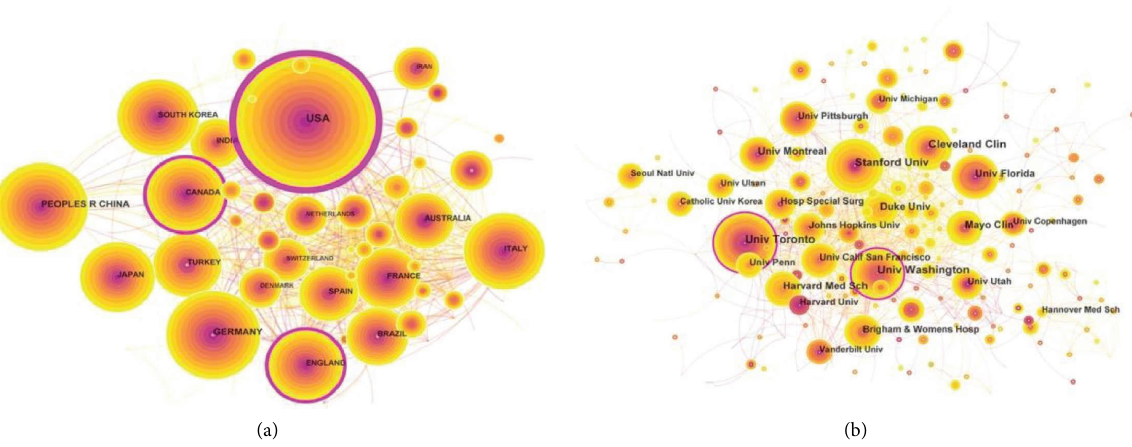
Figure 6: Maps of collaborative research on acute postsurgical pain among (a) countries and (b) institutions, 2012–2021.